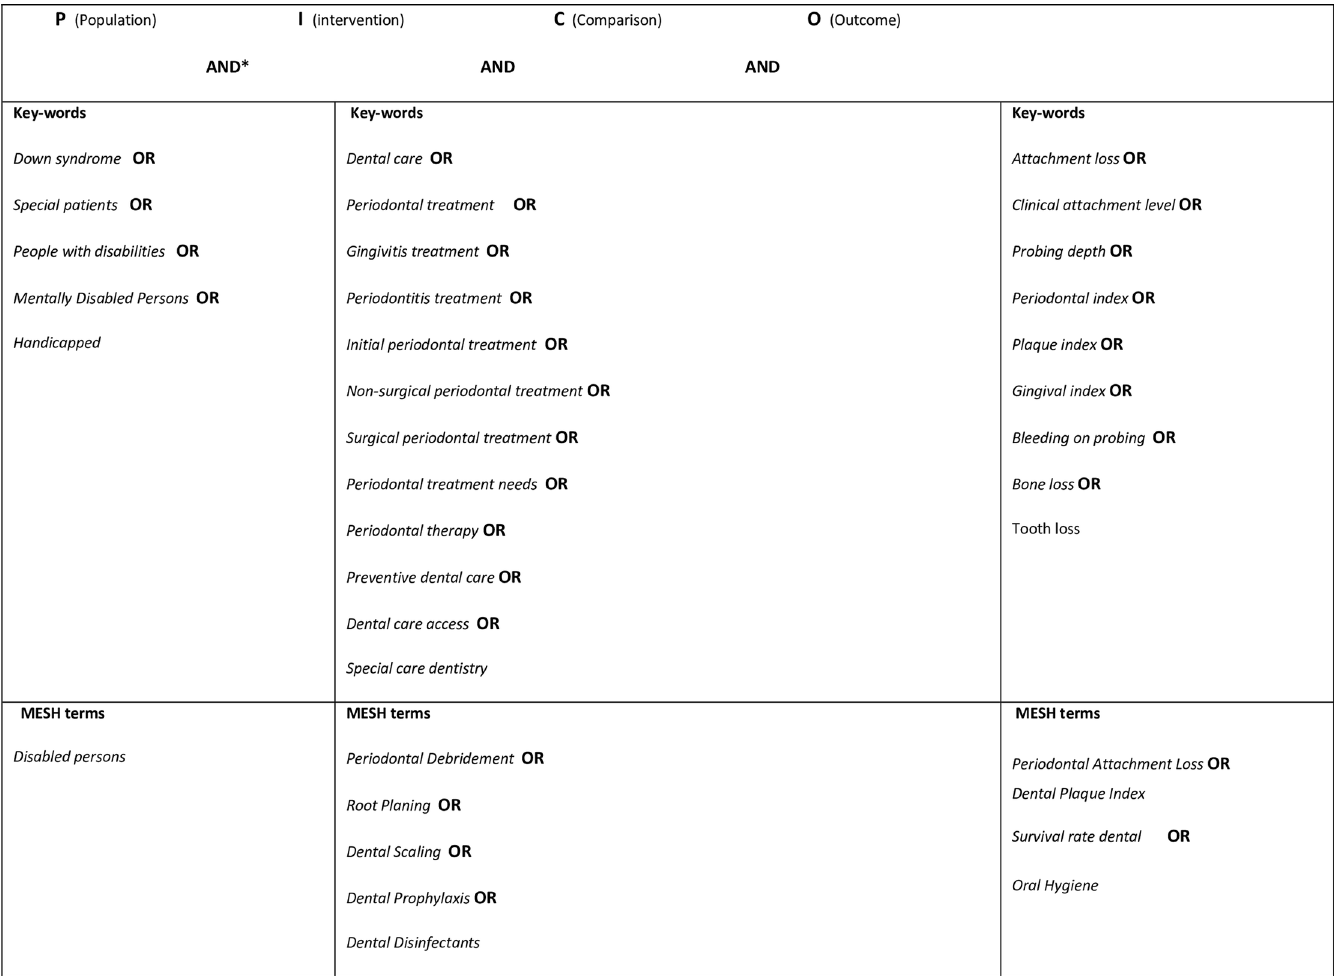
Fig 1. Electronic search according to the PICO scheme, with both Key-words and MESH